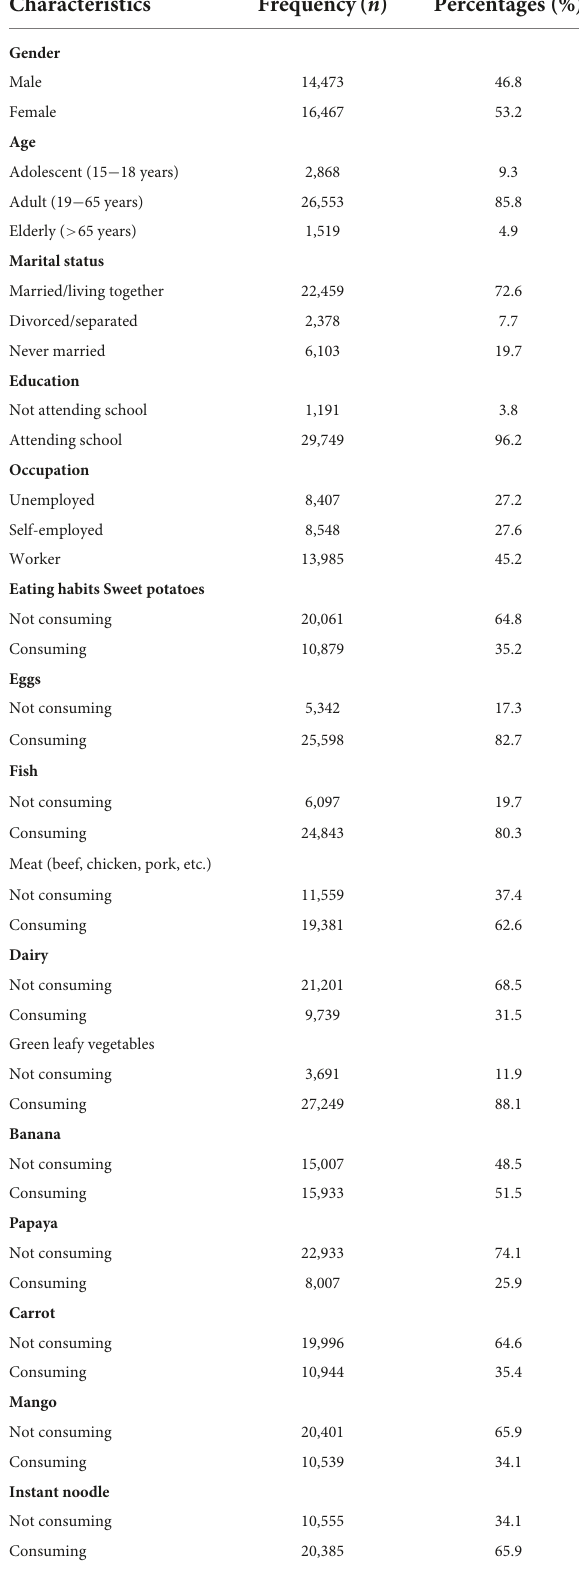
TABLE 1 Characteristic of study